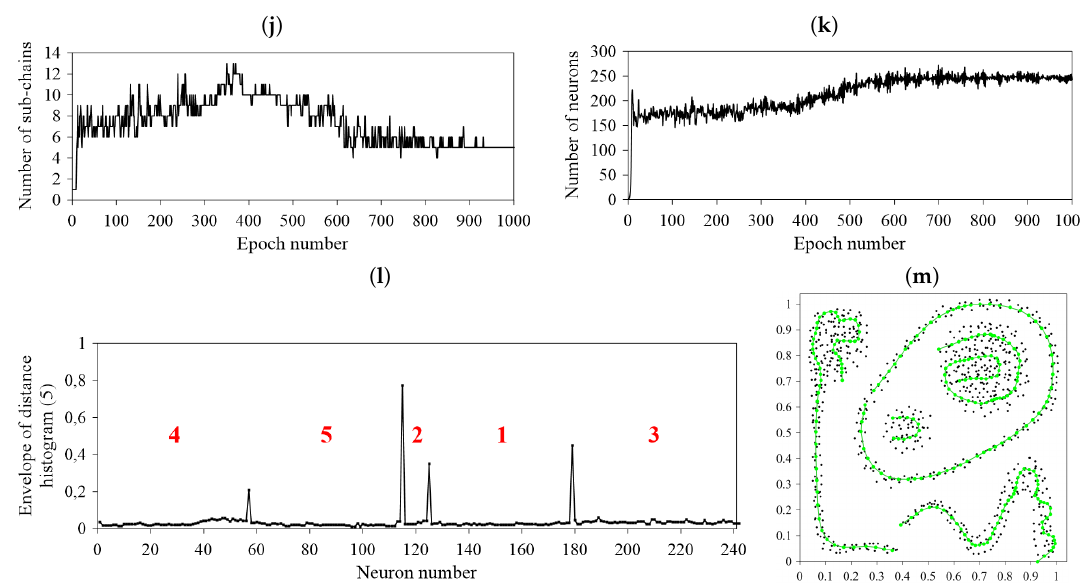
Figure 17. The evolution of GeSOM with 1DN (DSOM) in the synthetic data set of Figure 6a in learning epochs: ( a ) No. 0 (start of learning), ( b ) No. 5, ( c ) No. 10, ( d ) No. 20, ( e ) No. 50, ( f ) No. 100, ( g ) No. 300, ( h ) No. 500, and ( i ) No. 1000 (end of learning); moreover, plots of the number of sub-chains ( j ) and the number of neurons ( k ) vs. epoch number and ( l ) the distance histogram (5) for the network of Figure 17i as well as ( m ) the network in learning epoch No. 1000 for different starting point of the learning